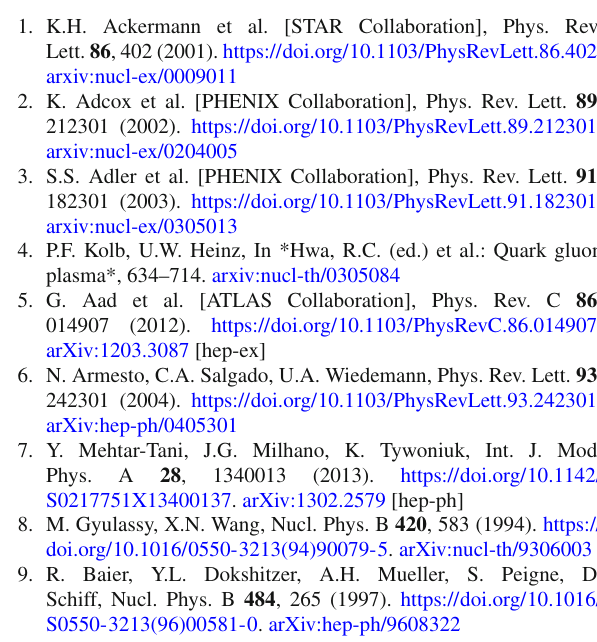
Fig. 7 The maximum stopping distance of the jet moving a in the x-direction and b in the z-direction the charged anisotropic back- ground with different chemical potential. The value of Q is 0, 3 and 4.5 for the purple, green and blue lines respectively. The charged